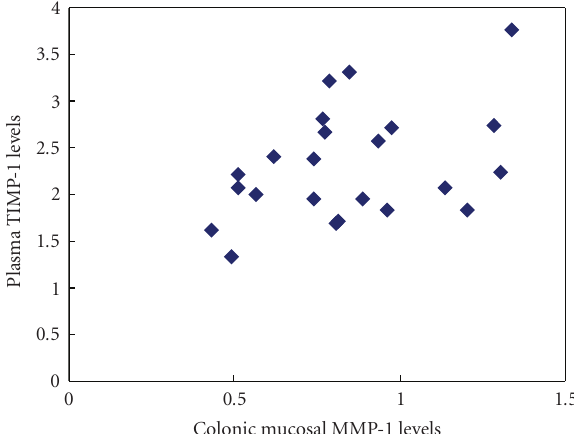
Figure 3: Correlation between plasma and mucosal MMP-1 expression.